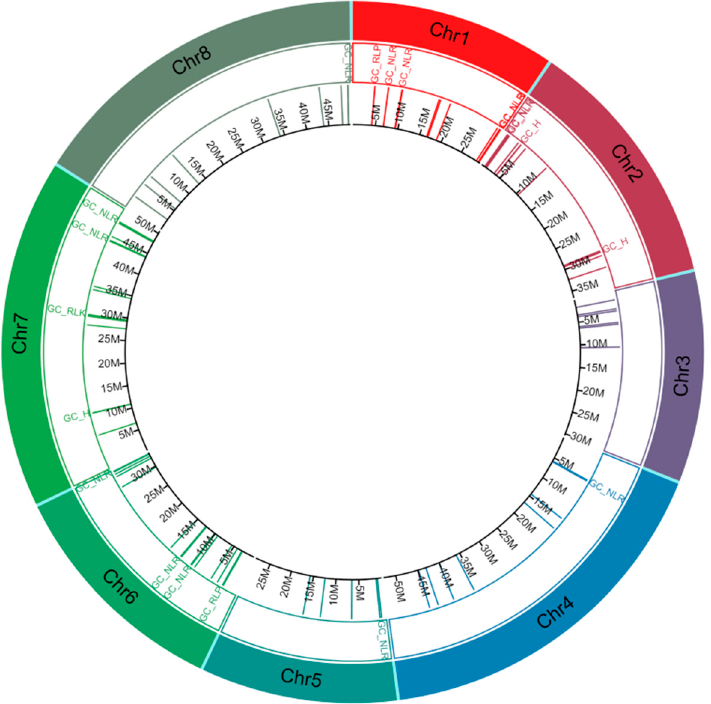
Figure 4. Distribution of cloned disease resistance gene homologs in Arabis alpina (1st inner layer in their corresponding position in A. alpina genome). The tracks in the circos plot, from outer to inner, show chromosome (Chr) number and types of gene cluster. GC_NLR = gene cluster (GC) with all nucleotide-binding site leucine rice repeats (NLR) members, GC_RLP = GC with all receptor-like proteins (RLP) members, GC_RLK = GC with all receptor-like kinase proteins (RLK) members, GC_H = GC with members are a mixture of NLR, RLK and/or RLP, Chr = chromosome and M = position in million base pairs.